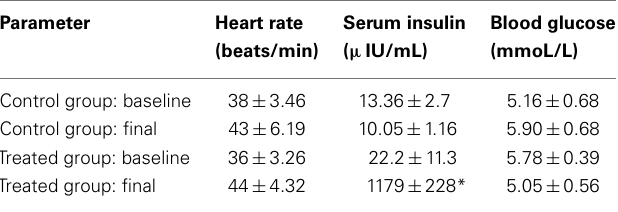
Table 1 | Mean ± SE heart rate, serum insulin, and blood glucose concentration before and after intravenous insulin infusion